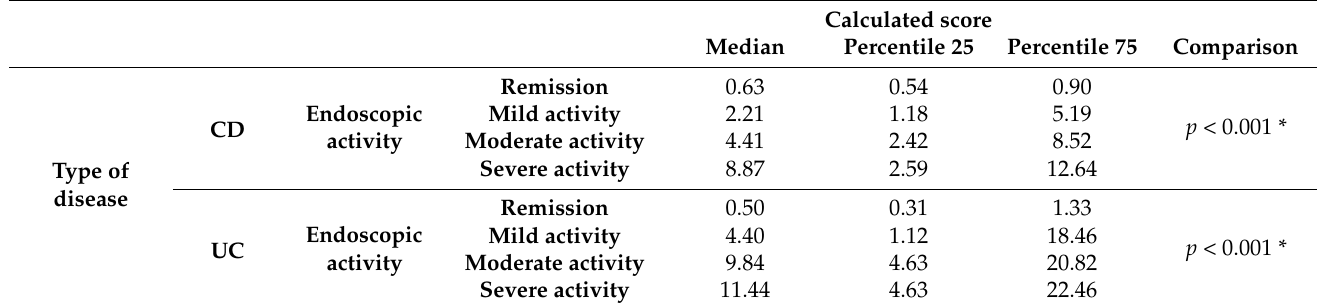
Table 8. Description of the activity score according to the subcategories of endoscopic